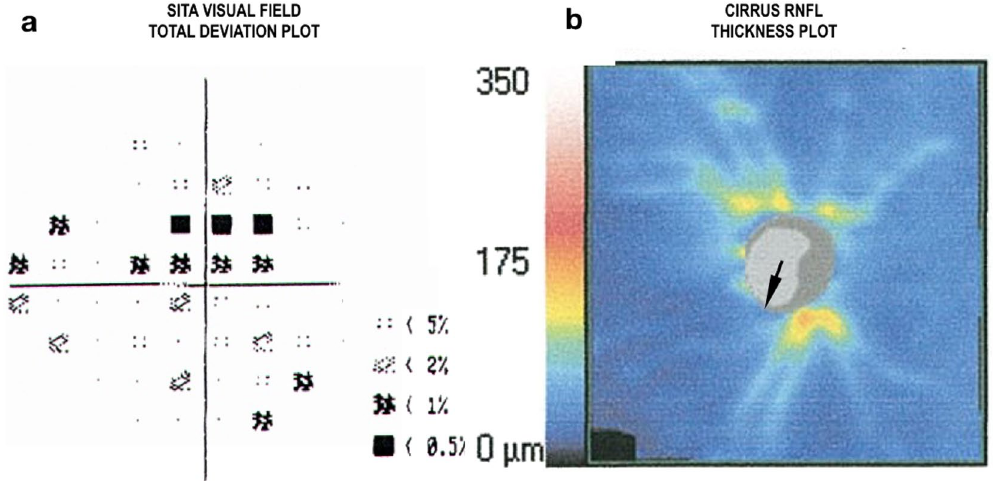
Figure 1. Clinical data of the glaucoma brain-dead organ donor. ( a ) Standard automated perimetry total deviation plot showing a superior arcuate defect and early inferior loss. ( b ) retinal nerve fiber layer thickness map from the patient’s clinical records showing rim notching (small arrow) and inferior > superior